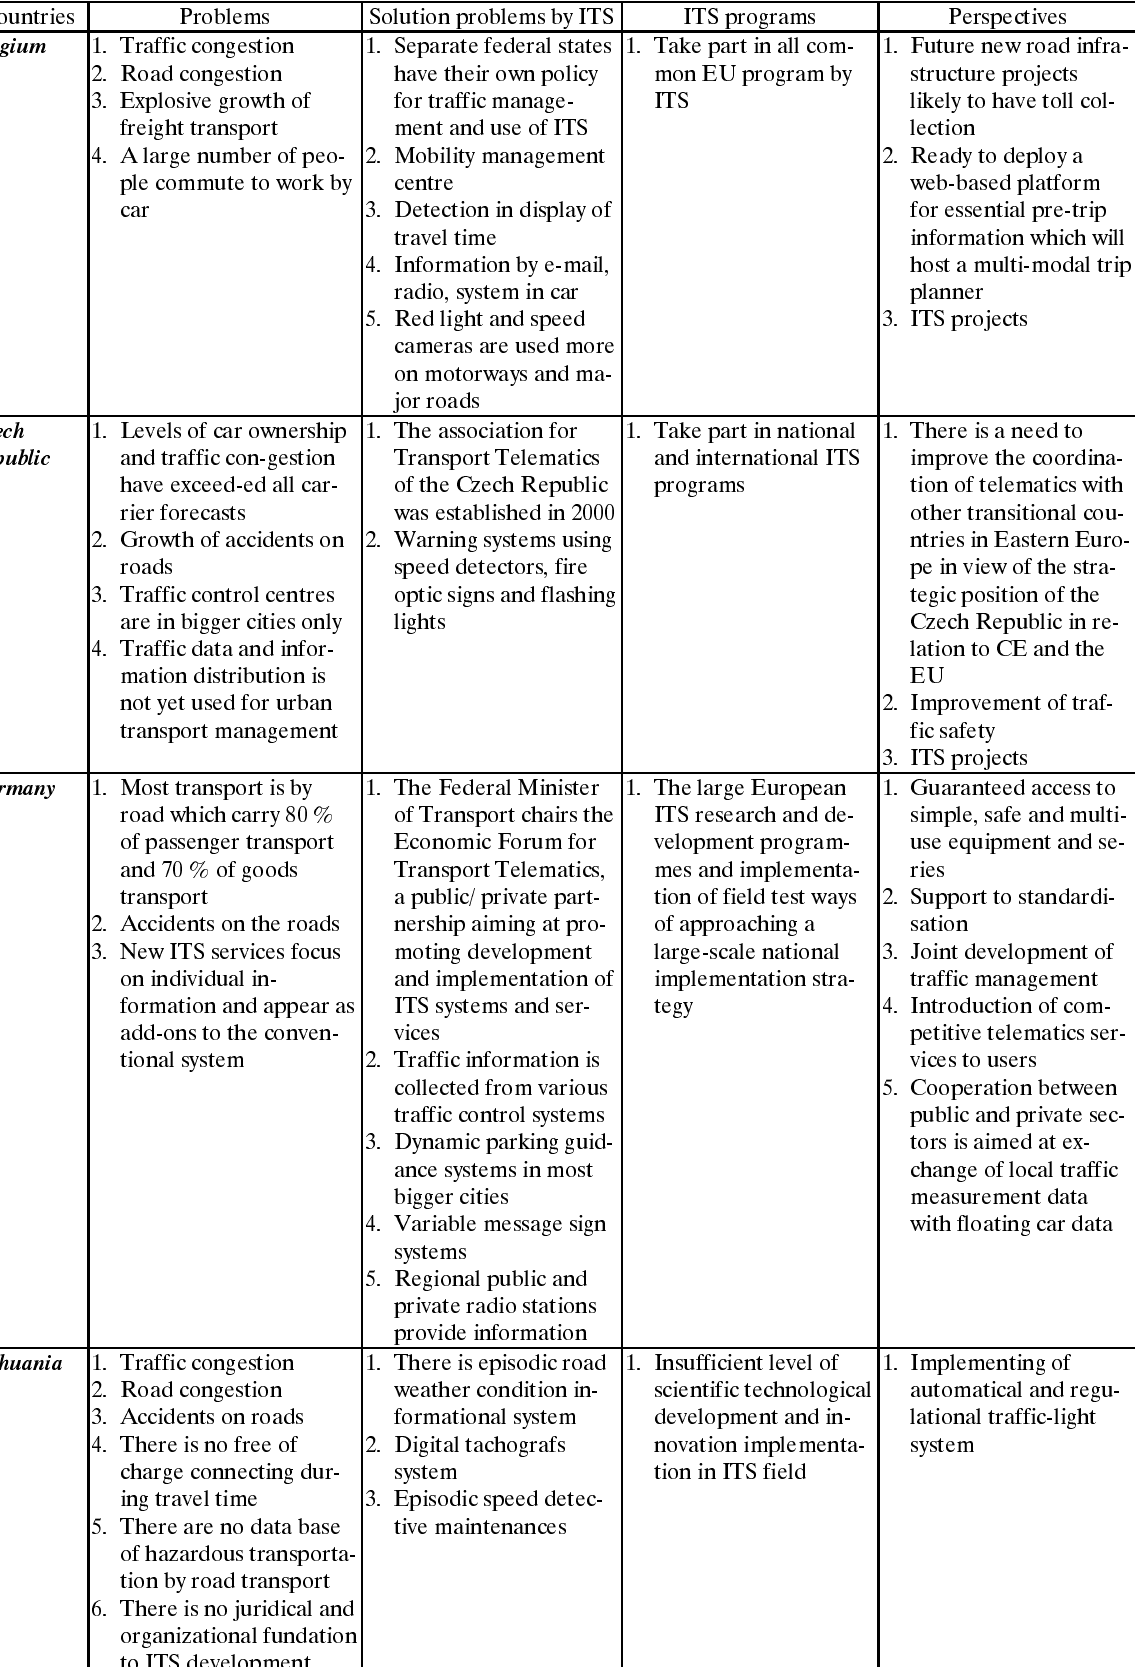
Table 1. Estimation of ITS situation in foreign countries and in Lithuania